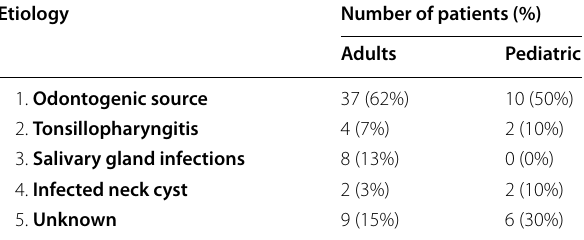
Table 1 Etiological factors in patients with DNSI Etiology